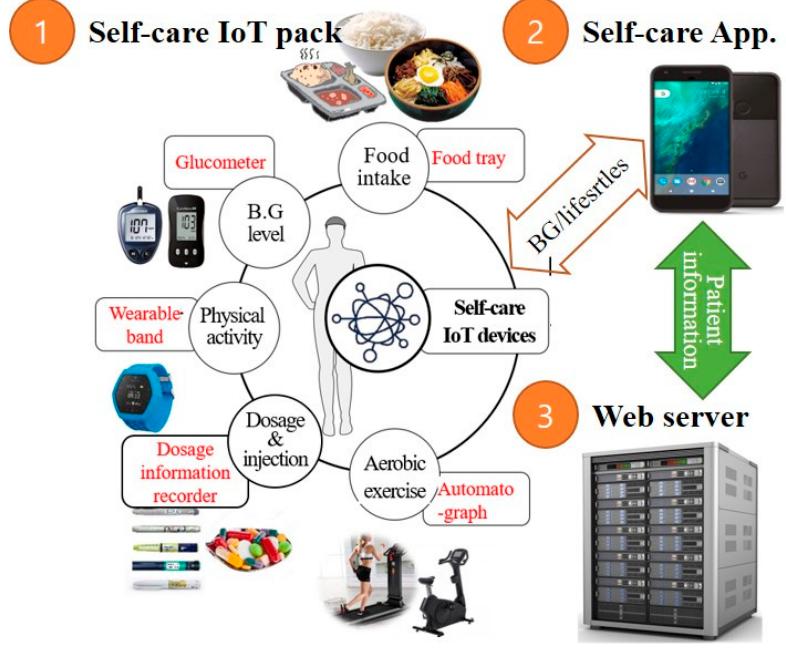
Figure 1. The proposed internet of things (IoT)-based self-care platform for diabetics.